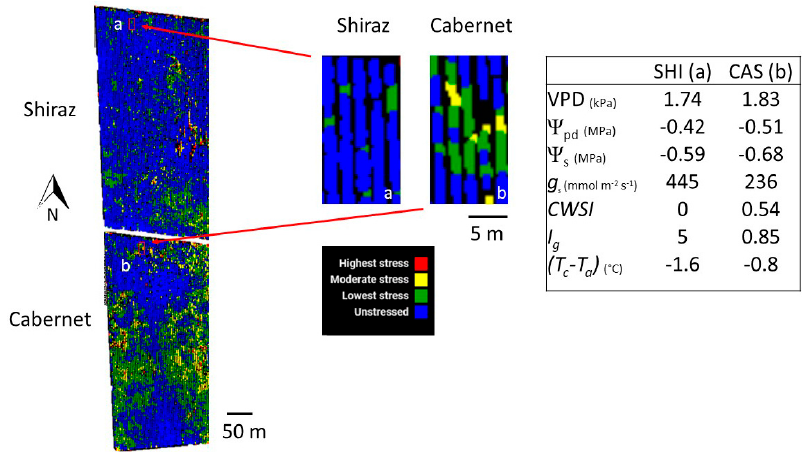
Figure 1. Water status of Shiraz and Cabernet Sauvignon under similar soil moisture as captured from manned aircraft [64].